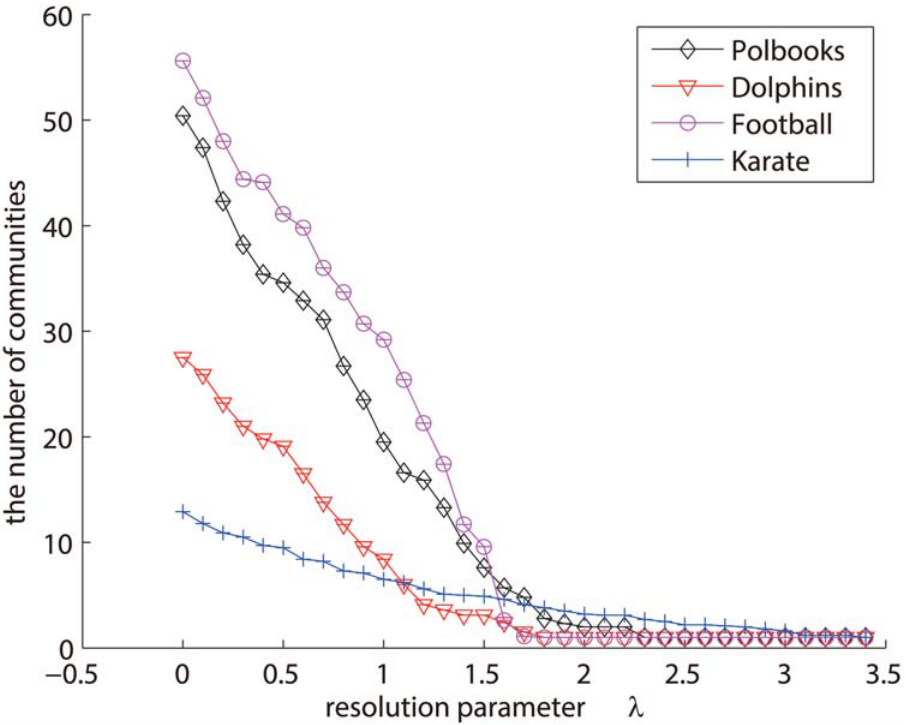
Fig 11. The number of communities at different scales. X-axis indicates the different λ , and Y-axis indicates the number of communities.